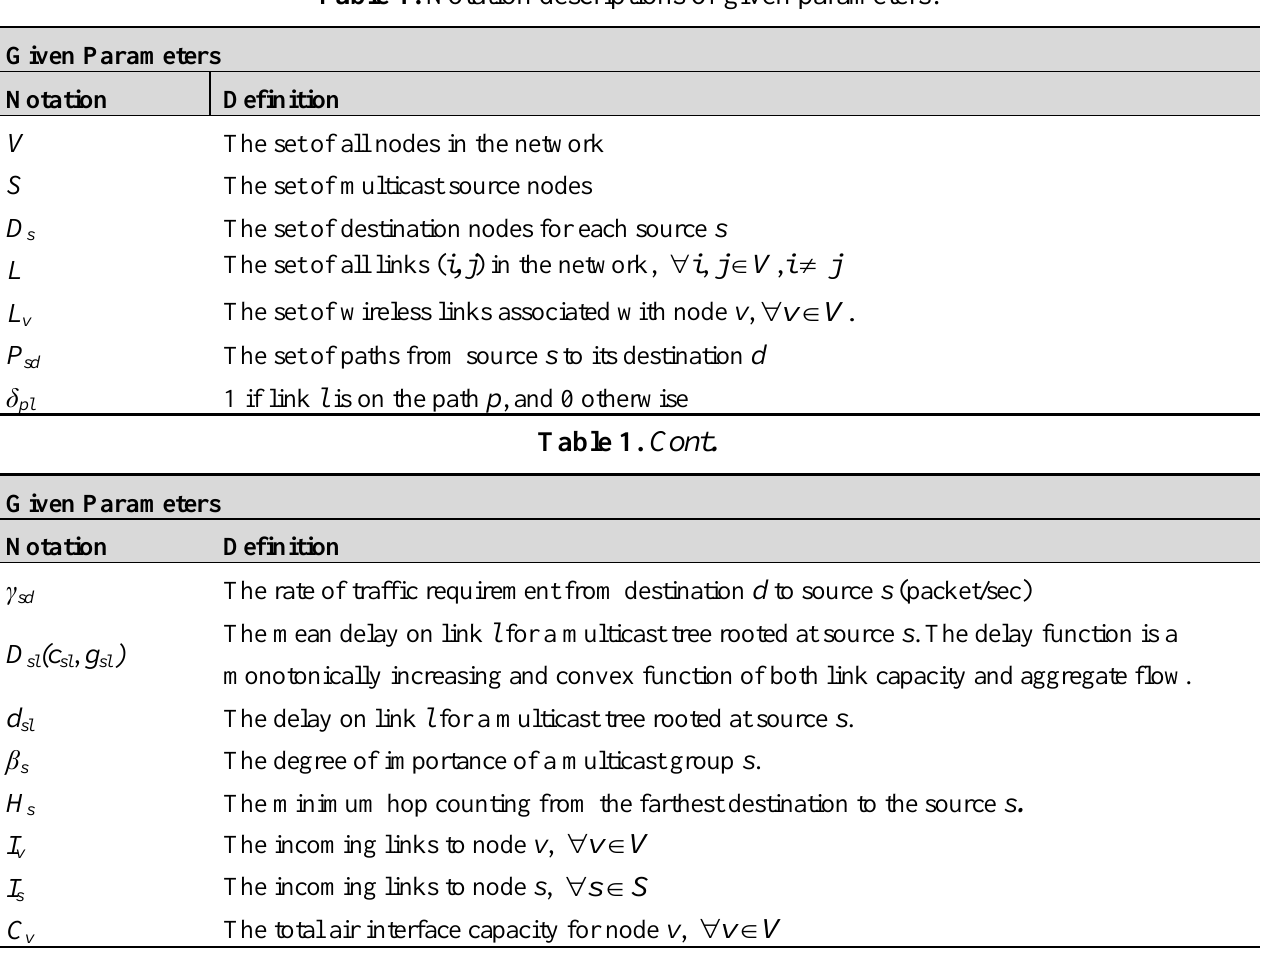
Table 2. Notation descriptions of decision